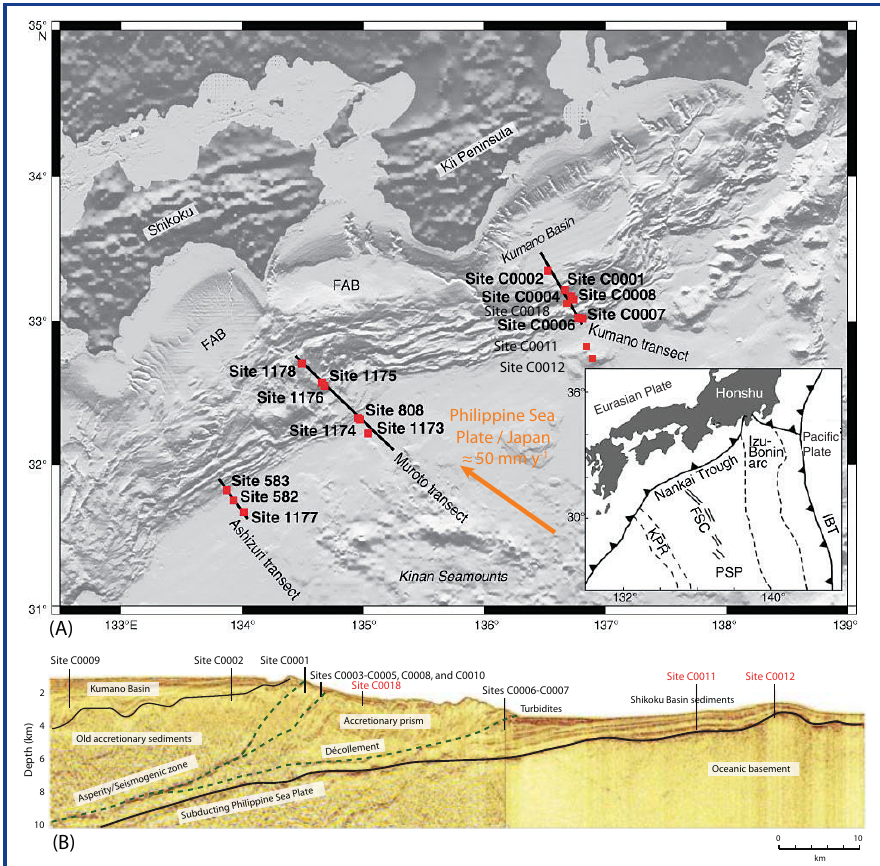
Figure 1. [A] Location map of Kumano, Muroto, and Ashizuri borehole transects across the Nankai Trough. FAB=Forearc Basin. [B] Spliced composite profile of a representative depth section from NanTroSEIZE 3D data volume (Moore et al., 2009) and Line 95 from IFREE mini-3D seismic survey (Park et al., 2008). Projected positions of Stage 1 and 2 drilling sites, including sites C0018, C0011, and C0012, are